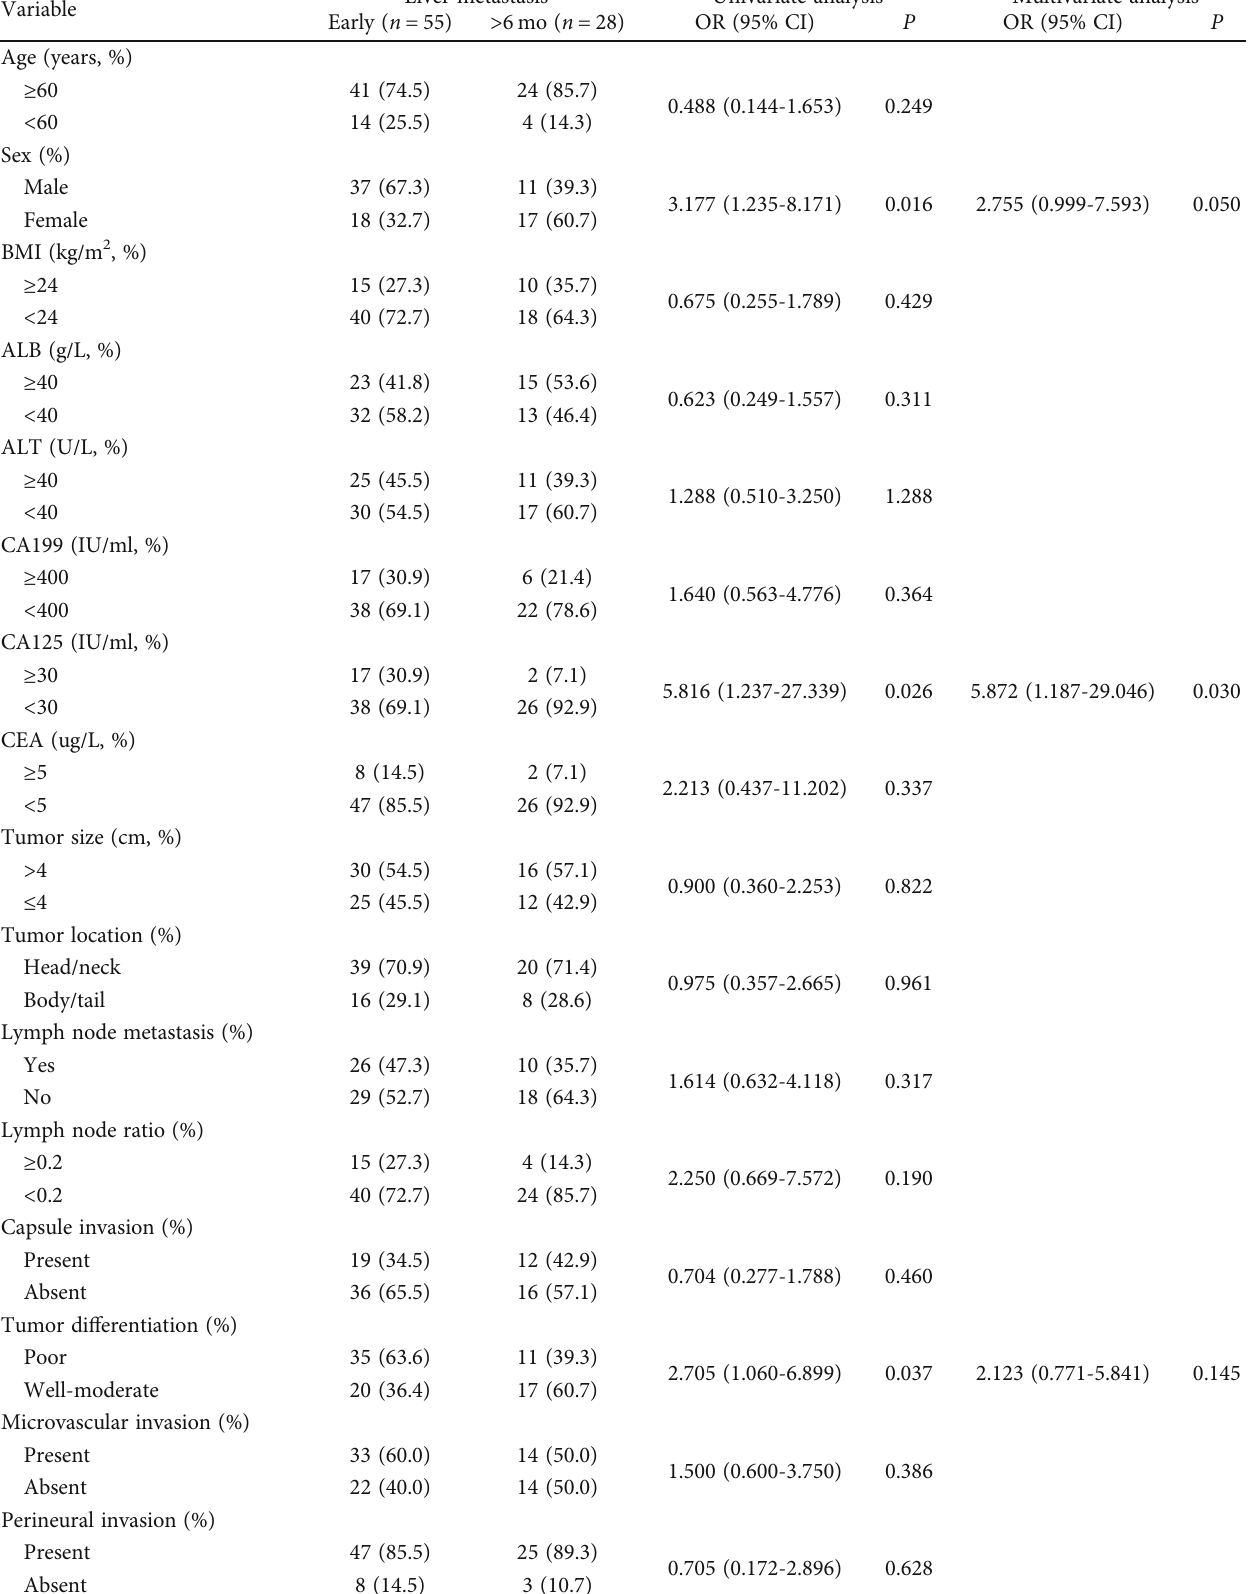
Table 5: Analysis of risk factors by comparison with liver metastasis after